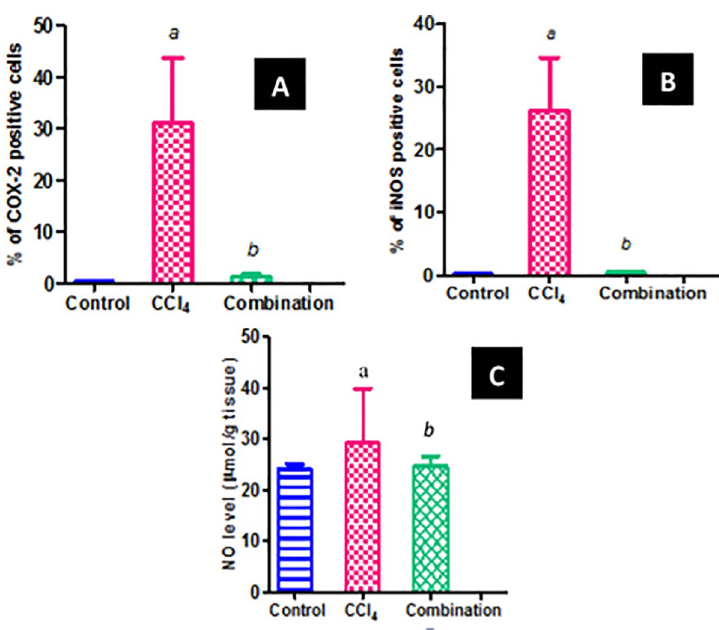
Fig 4. Effect of P . niruri AE (100 mg kg -1 day -1 ) on COX-2 and iNOS. (A) % of COX-2; (B) % of iNOS positive cells as measured by image analysis; (C) NO levels; a : significantly different from control group; b : significantly different from CCl 4 group.